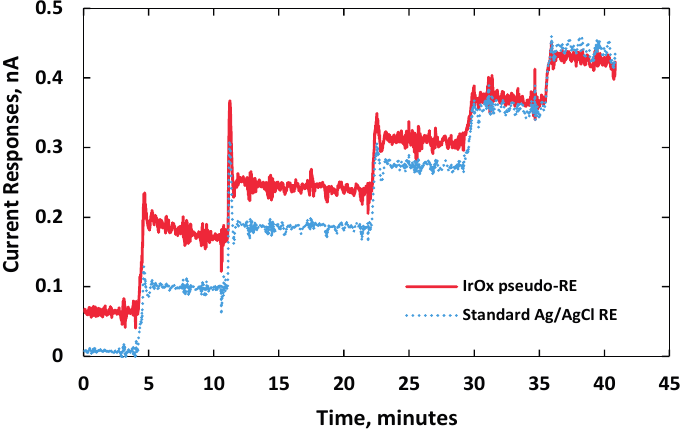
Figure 7. Electrical current responses of two DA sensors for incremental additions of 2.5- μ M dopamine to 40 mL of 0.05-M PBS solution. Both sensors had identical gold WEs but with different REs: (red) the planar IrO x pseudo-RE; and (blue) a standard glass-tube Ag/AgCl